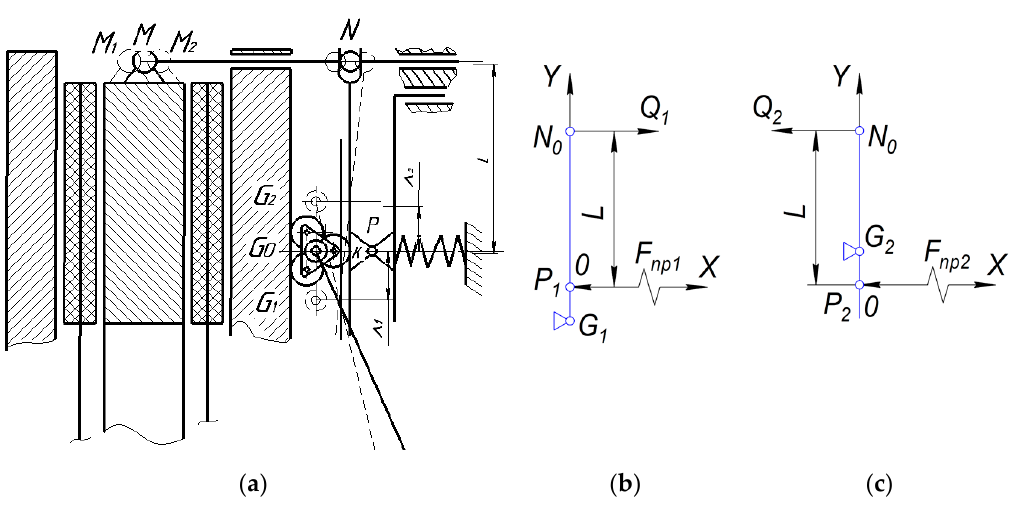
Figure 4. The original DCT: ( a )—the design scheme; ( b )—1st clutch; ( c )—2nd clutch.